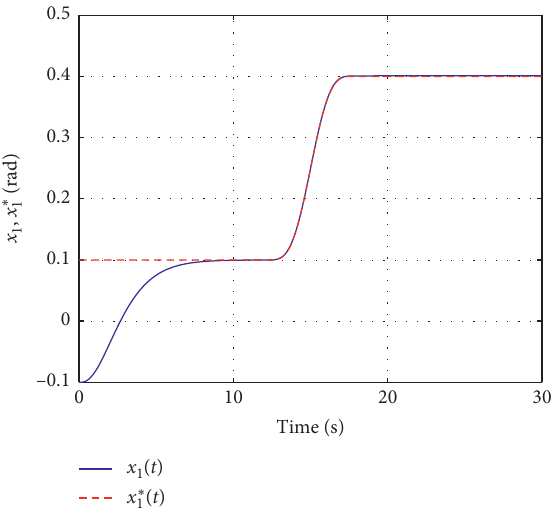
Figure 2: Output tracking response for a rest-to-rest trajectory.